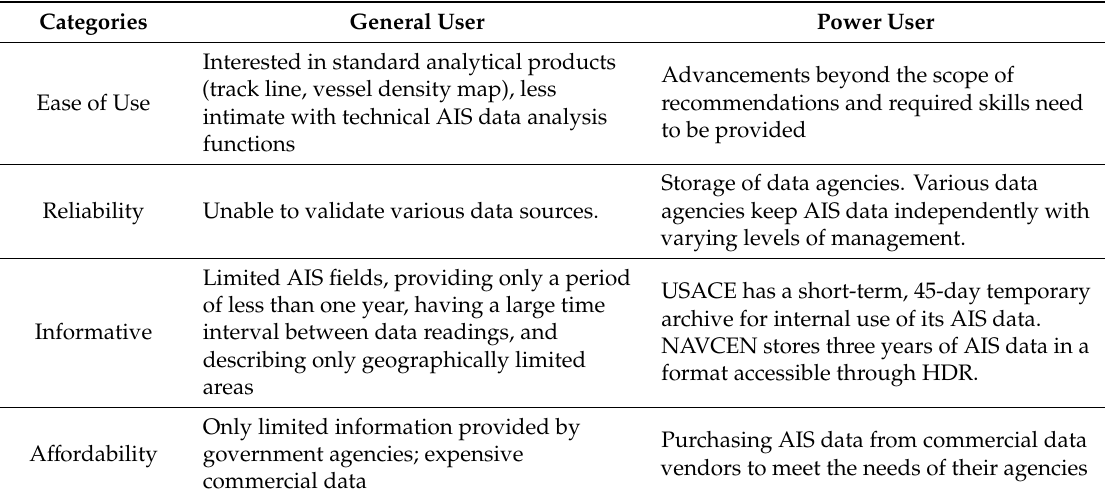
Table 2. Challenges and barriers for using AIS and derived-AIS